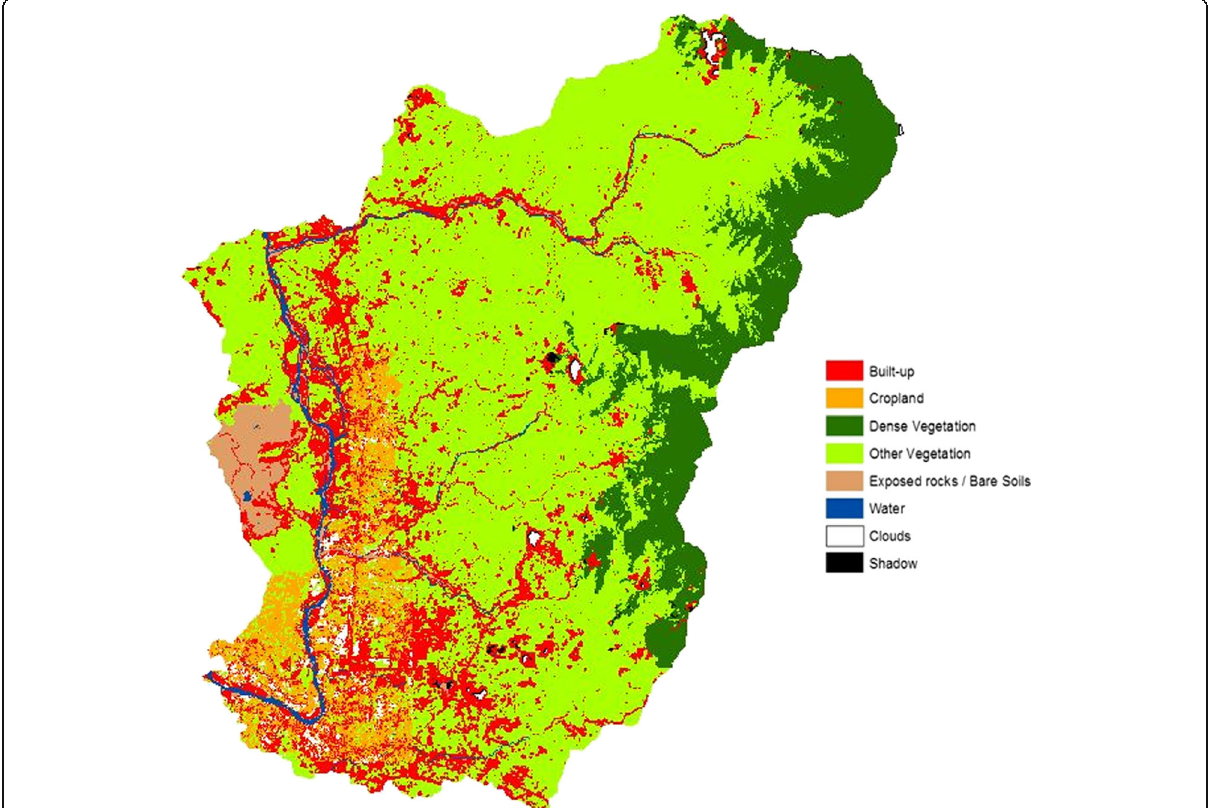
Fig. 4 Land cover map of Tubay catchment derived from Landsat 8 OLI image